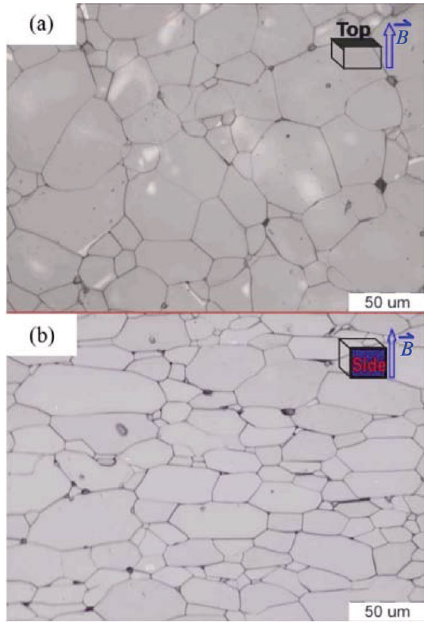
Fig. 2 OM thermal etched surfaces of textured alumina ceramics: (a) perpendicular to the magnetic field direction; (b) parallel to the magnetic field direction. Reproduced with permission from Ref. [68], © Elsevier Ltd and Techna Group S.r.l. 2012.